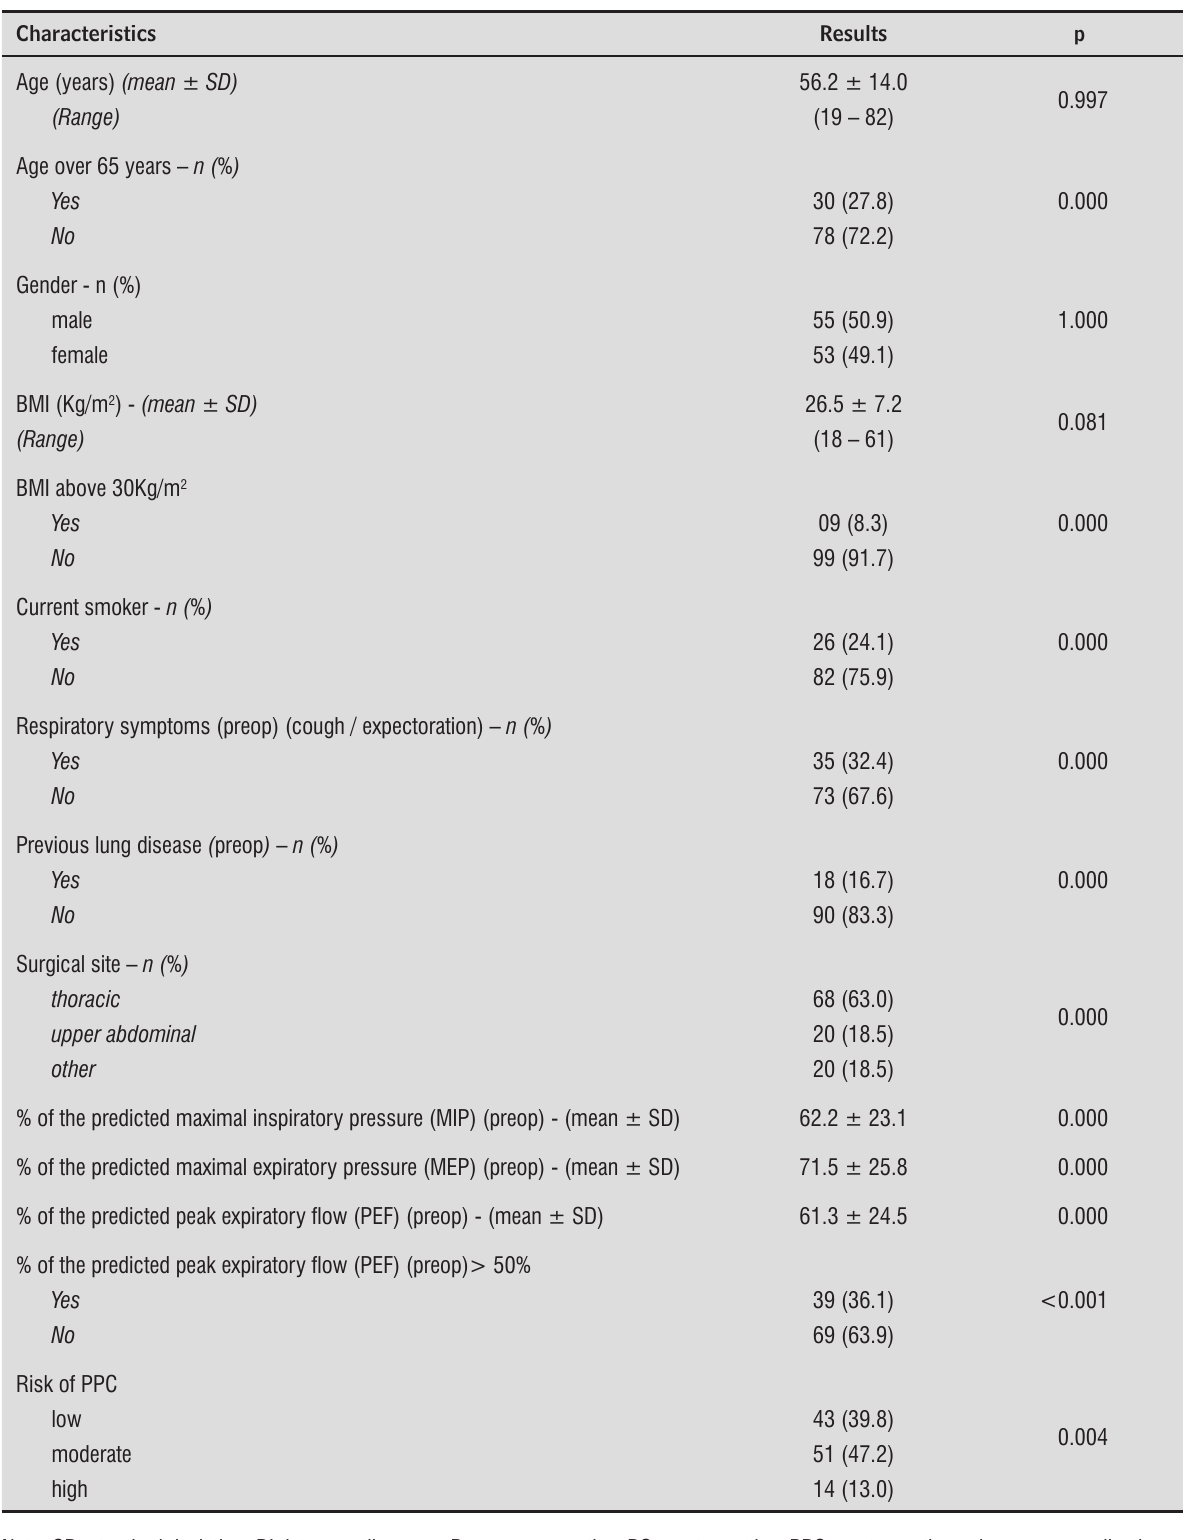
Table 2 - Characteristics of the patients